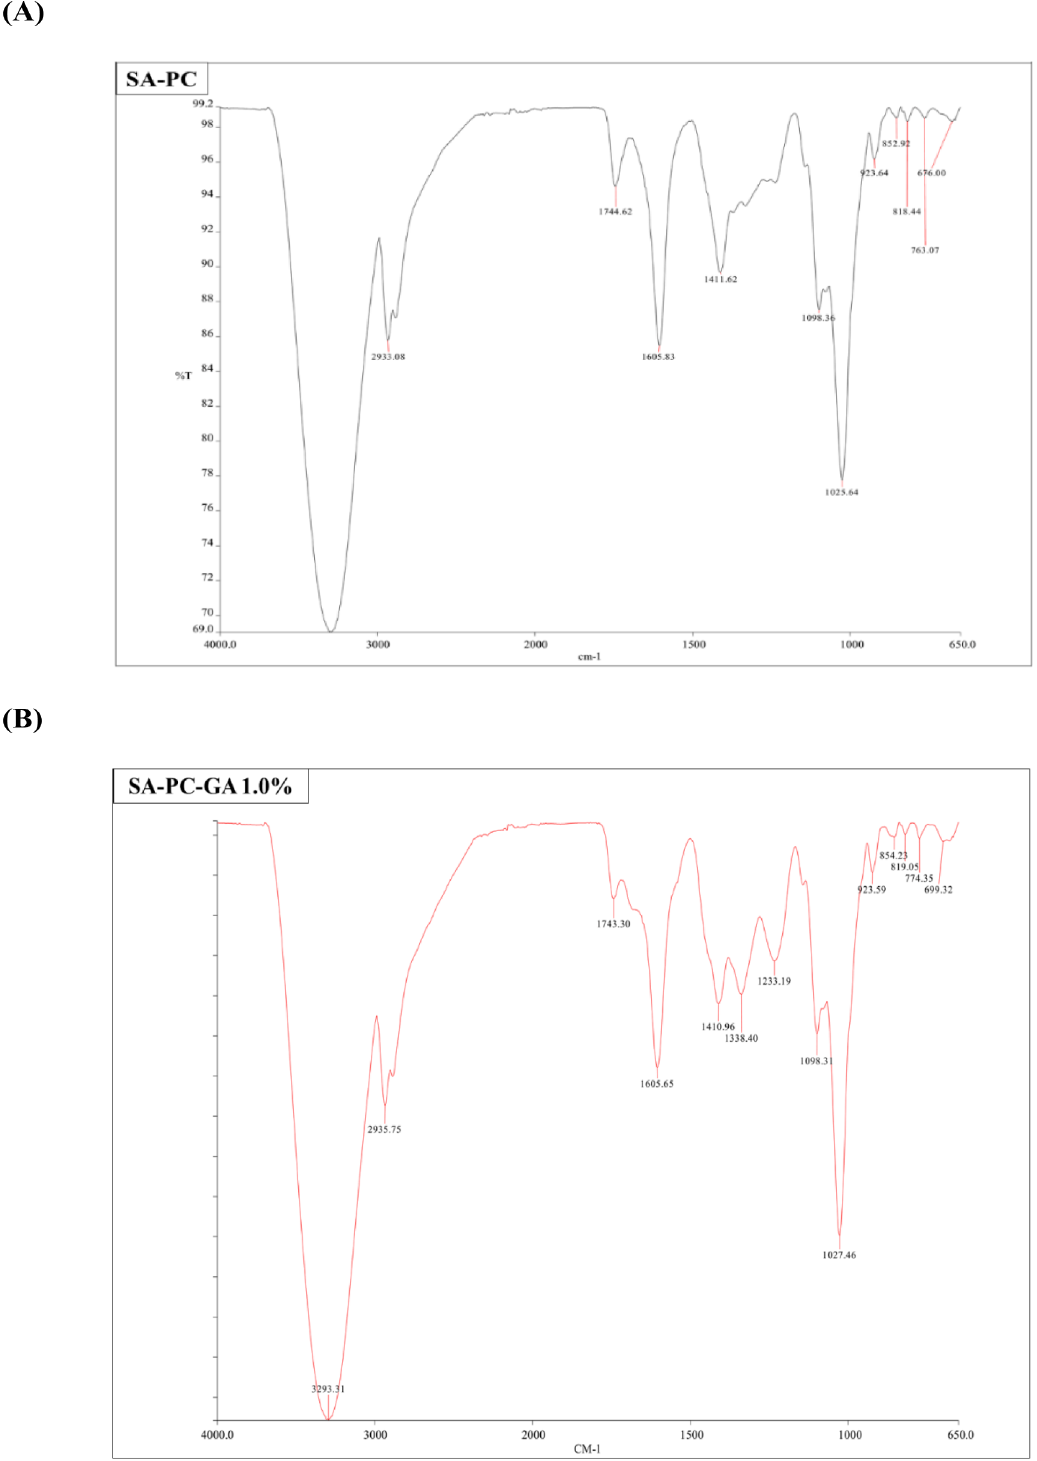
Figure 2. FTIR spectra of (A) Blank SA-PC film, (B) Gallic acid-loaded film (SA-PC-GA 1.0 % ). * Abbreviations: SA, sodium alginate; PC, pectin; GA, gallic